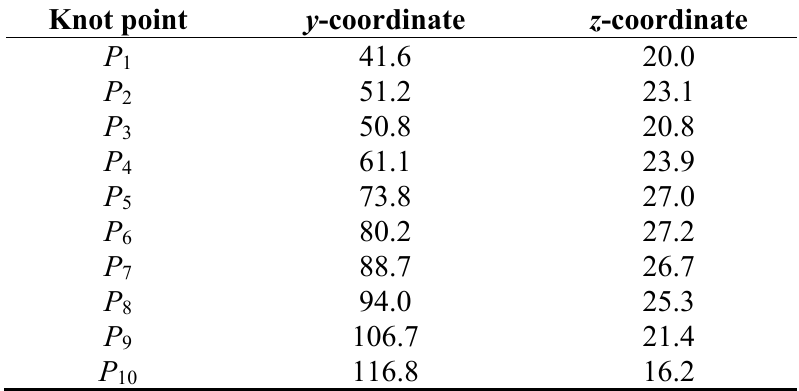
Table 5. Parameters of the applied segmented line filter.